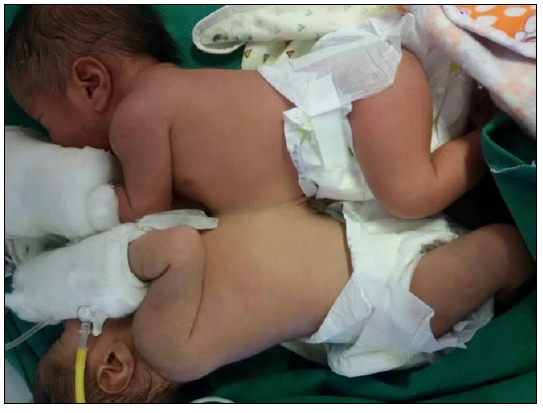
Figure 1: Omphalopagus twins at birth Ultrasonography of abdomen revealed fusion of liver and separate organ systems. Doppler